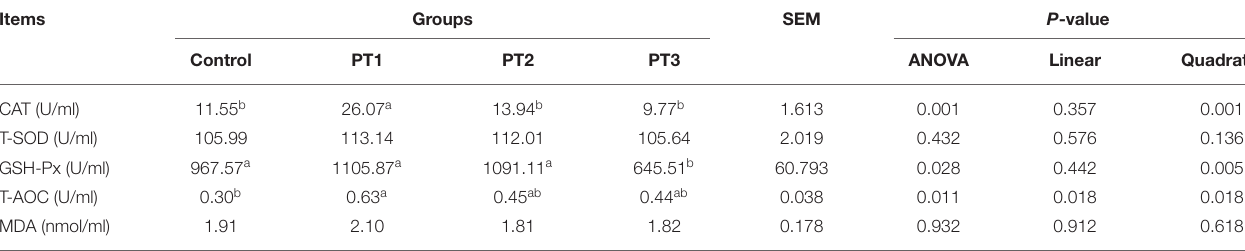
TABLE 3 | Effects of Plotytarya strohilacea Sieb. et Zuce tannin on serum antioxidant activity of broilers at 42 days of age. Items Groups SEM P -value